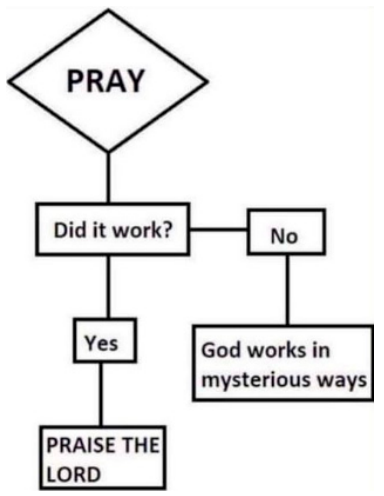
Figure 2. © unknown. Figure 2. ©